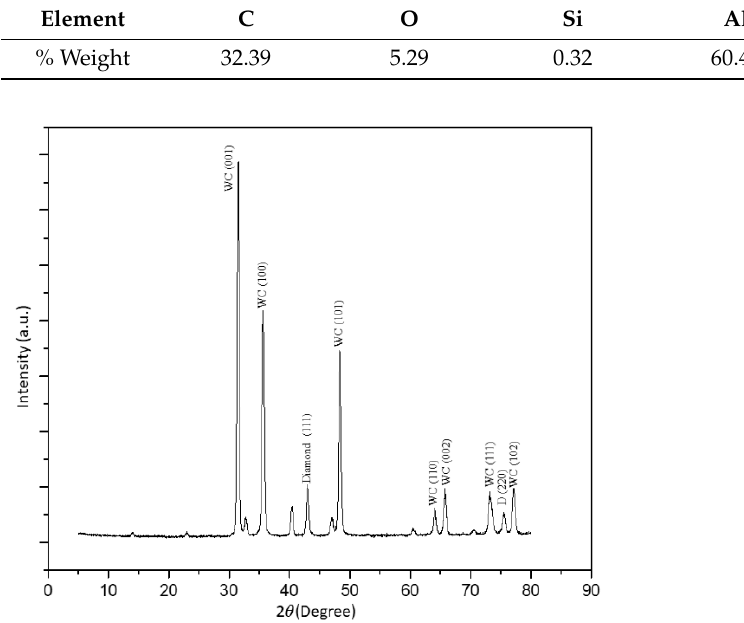
Figure 7. The X-ray diffraction spectra of the DLC-coated tungsten carbide tool.